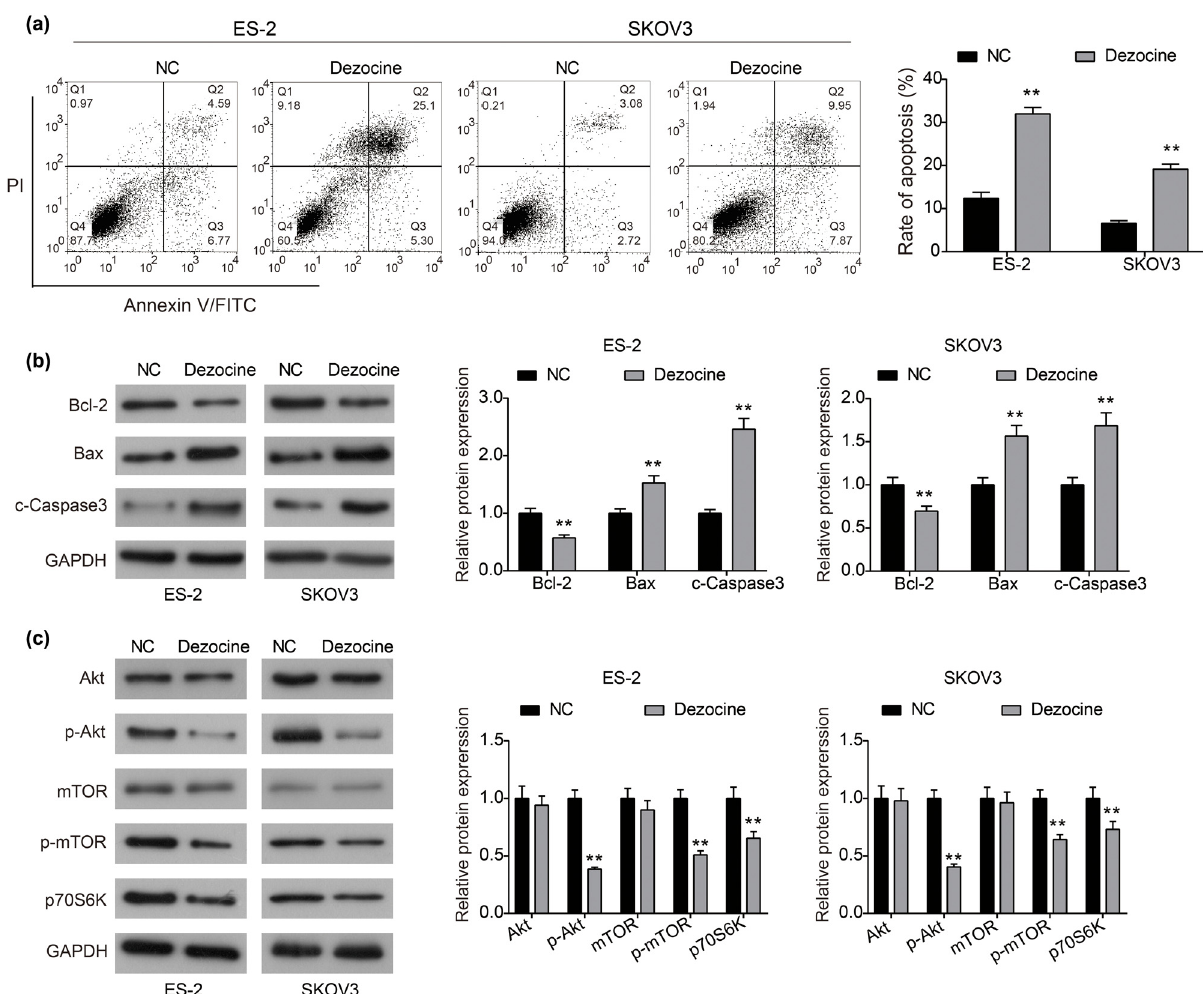
Figure 3: Dezocine promotes apoptosis of ovarian cancer cells and inhibits the Akt/mTOR signaling pathway. ( a ) Cells were treated with dezocine for 24 h, the percentage of apoptotic cells was analyzed by fl ow cytometry. ( b ) Western blot analysis of the expression of apoptosis - related proteins, Bcl - 2, Bax, and cleaved Caspase 3 in ES - 2 and SKOV3 cells treated with dezocine. ( c ) Expression of important components involved in the Akt/mTOR signaling pathway in ES - 2 and SKOV3 cells, including Akt, p - Akt, mTOR, p - mTOR, and p70s6k. ** P <